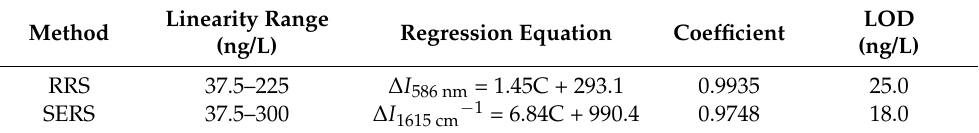
Table 1. Working curve of RRS/SERS for measuring OTC.